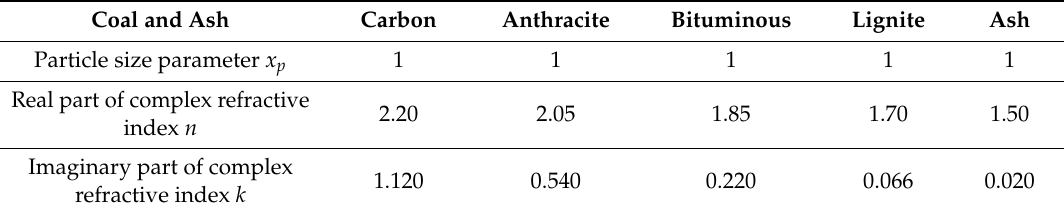
Table 4. Complex refractive index for di ff erent coals and ashes in-near infrared region.